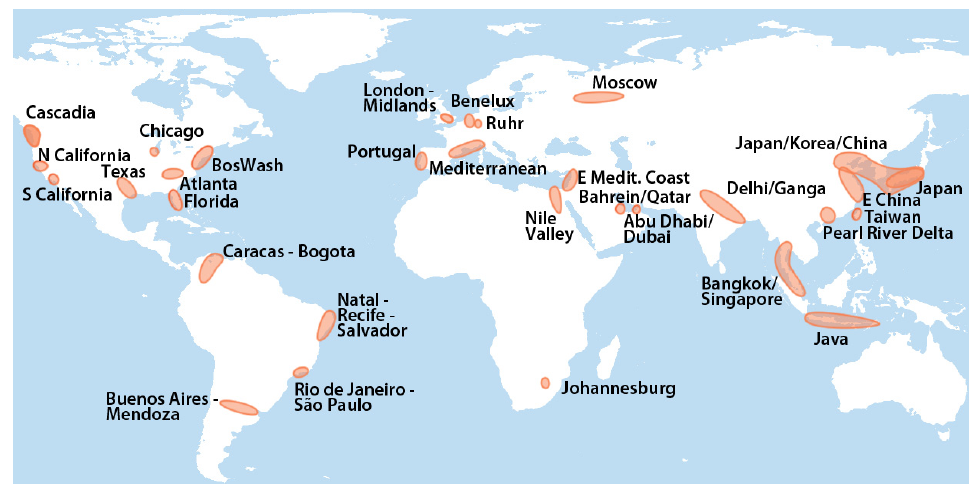
Figure 5. Urban corridors identified by participants of the questionnaire (areas marked by two or more participants). The map shows areas with strong agreement but the actual extents vary.